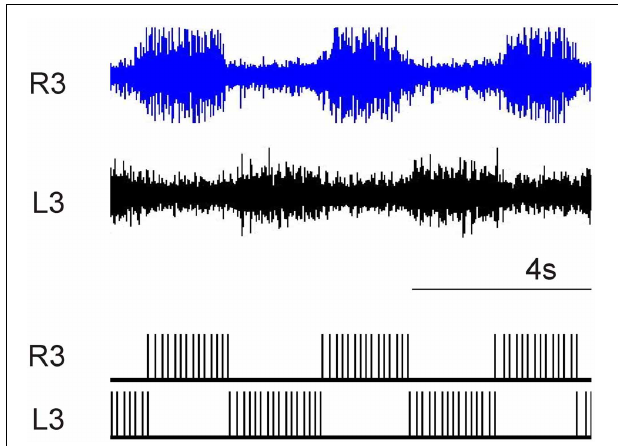
FIGURE 7 | Comparison of pharmacological in-vitro spinal cord with digital